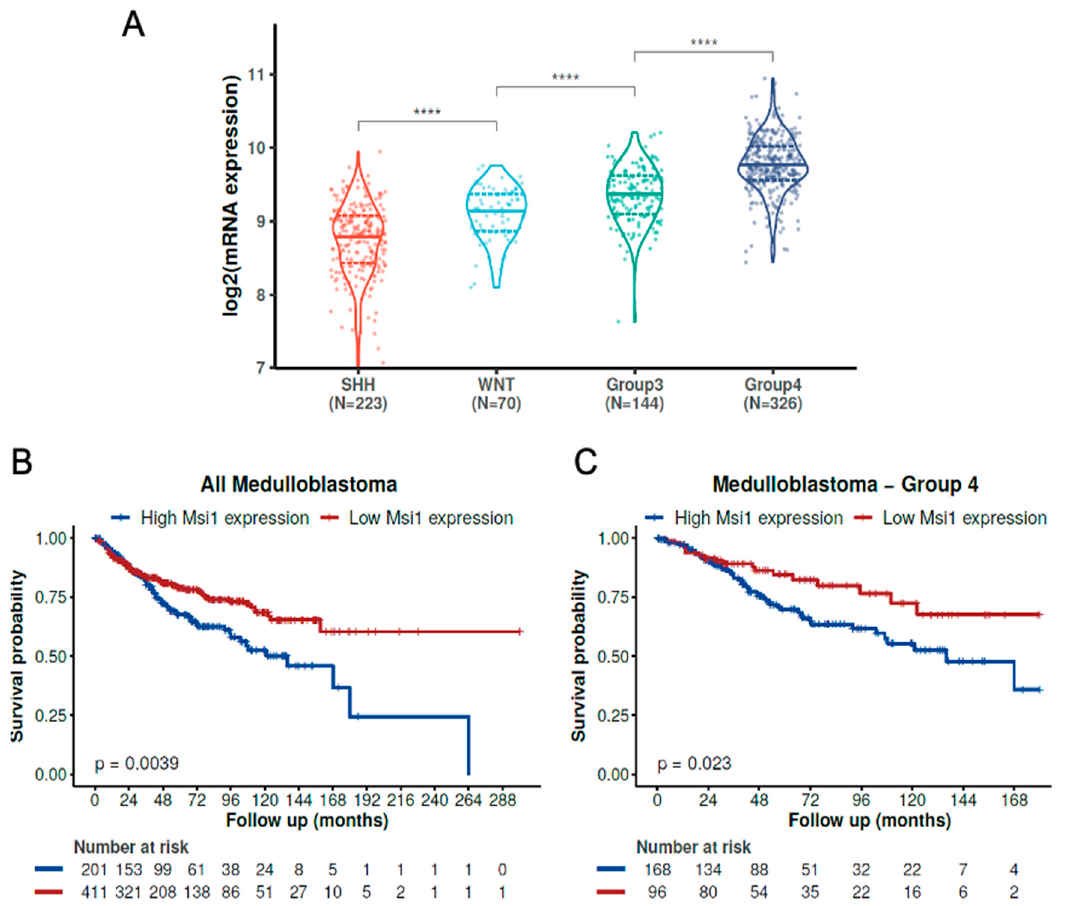
Figure 1. High Musashi1 expression is associated with a worse prognosis in Group 4 medulloblastoma . ( A ) Msi1 expression in MB molecular subgroups (**** p < 0.0001; Wilcoxon tests). Kaplan–Meyer curves show the impact of Msi1 expression levels on the survival of all MB patients ( B ) and only Group 4 MB patients ( C ) from the Cavalli cohort [10]. All significant comparison ( p ‐ value < 0.001; Wilcoxon test) are presented by “****”.